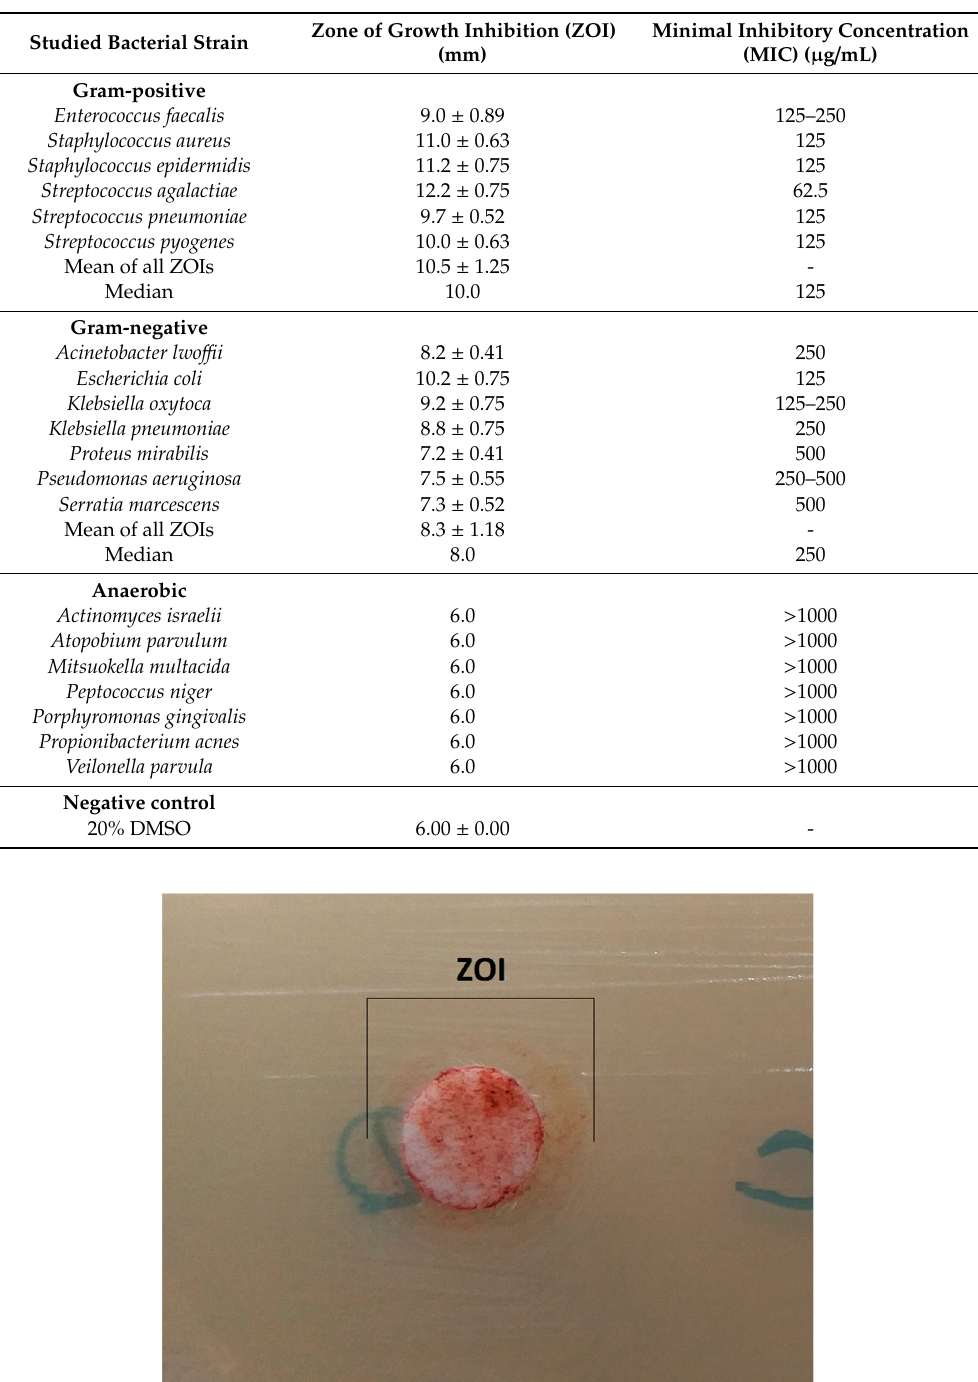
Figure 2. Culture of Escherichia coli strain. It is a visible zone of growth inhibition (ZOI) around the disk with 25 µg of fucoxanthin. Table 1. Antibacterial activity of fucoxanthin determined by the agar disc-diffusion and micro- dilution methods.